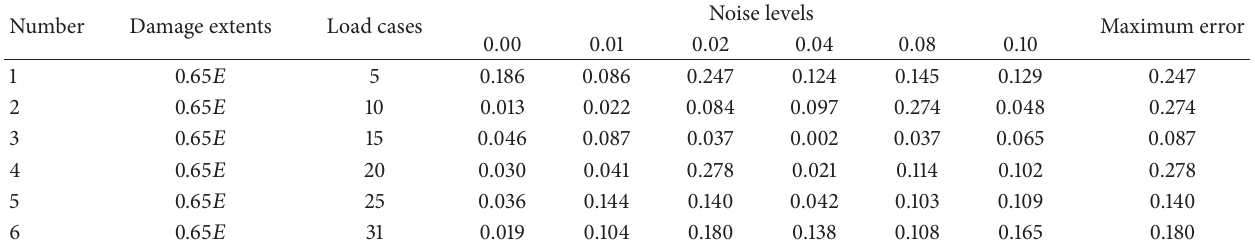
Table 18: The identification errors of forecasted cases based on strain damage parameters.